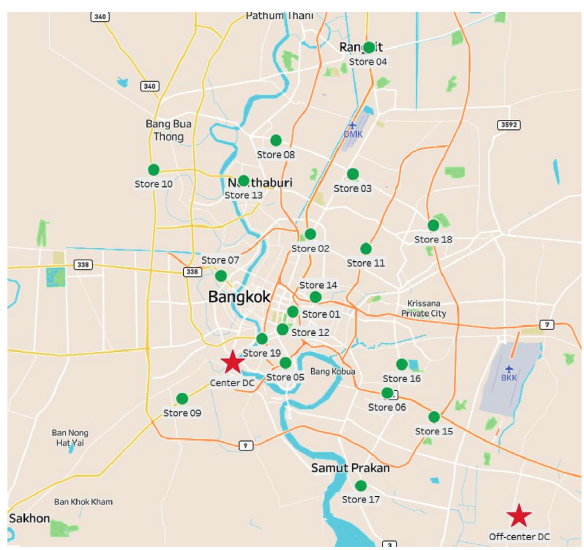
Figure 2: Example of a small problem instance. Table 2: List of set T